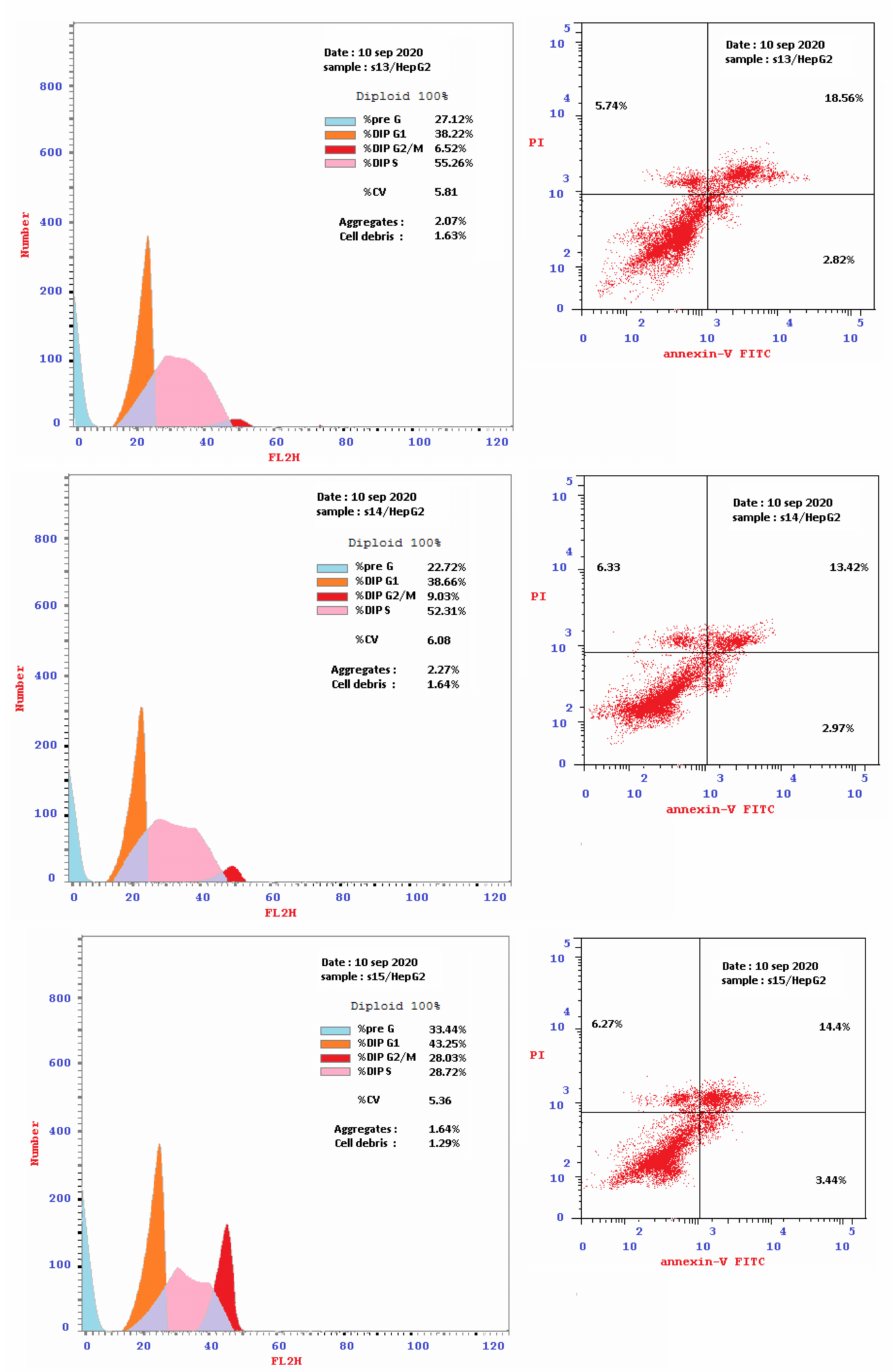
Figure 3. Flow cytometry cancer cell cycle distribution (Left) and apoptotic status (Right) for HepG2 liver cancer cells. Monolayer cells of HepG2 were treated separately for 48 h with the IC 50 of compounds 13 , 14 and 15